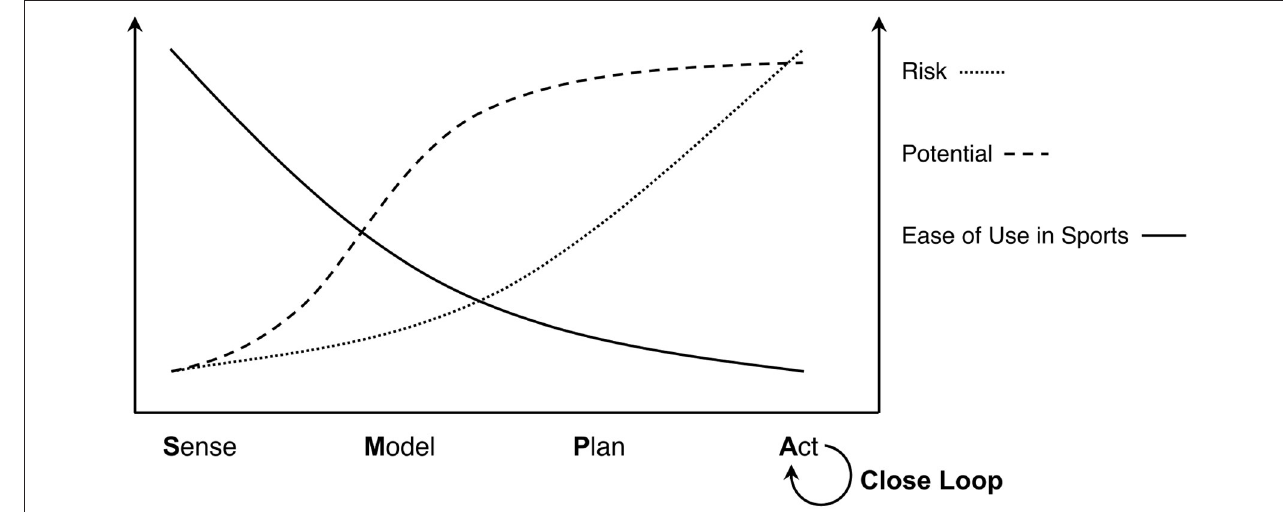
FIGURE 3 | Risk, potential and ease of use in sports of the four steps in SMPA